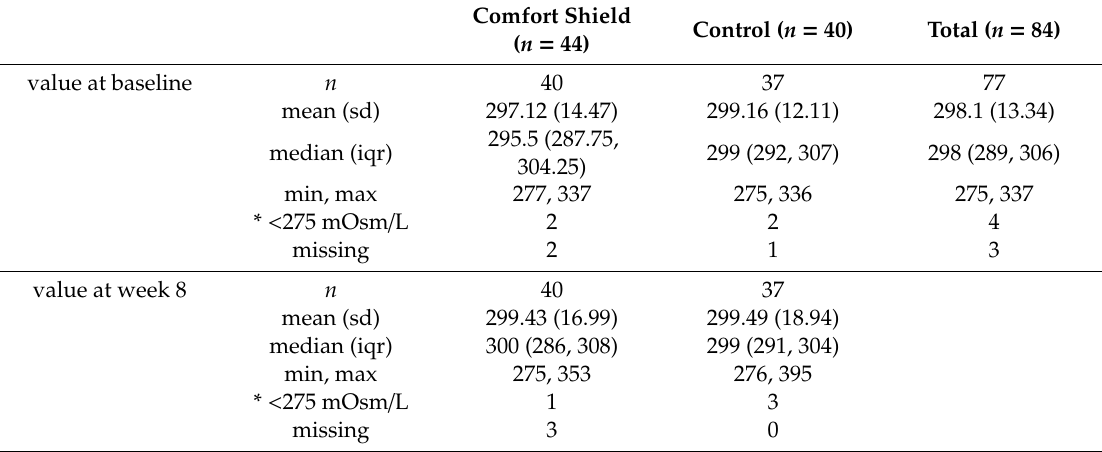
Table A2. Osmolarity: value in mOsm / L at baseline and at week 8—PPS ( n = 84)—Descriptive analysis, by treatment arm.